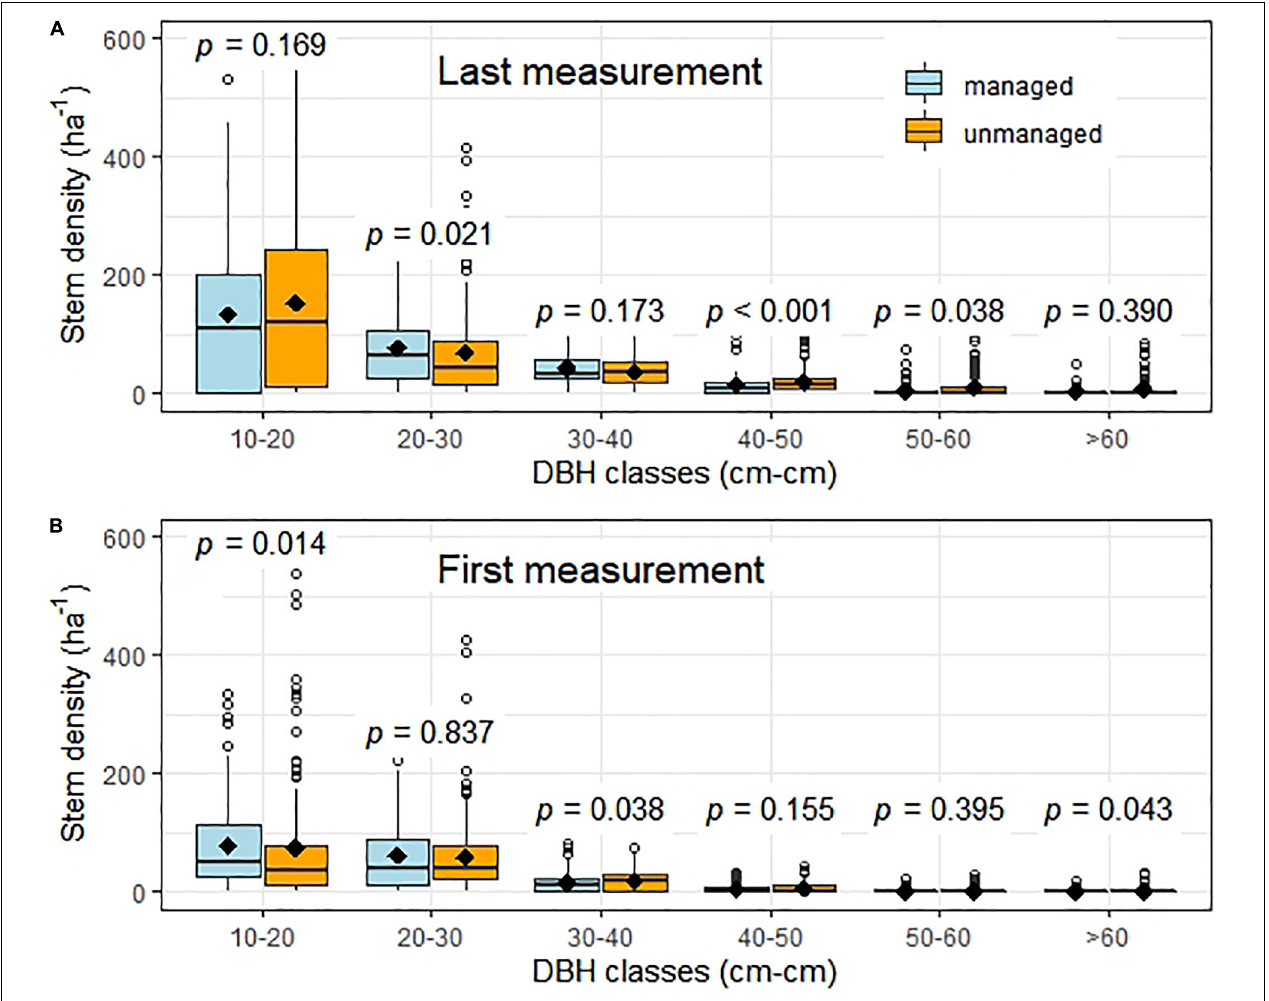
FIGURE 5 | Stem density distribution using 10 cm classes of diameter at breast height (DBH) for managed (left) and unmanaged plots (right). In panel (A) , we show results for the last measurement and in (B) for the first measurement. For details on boxplots see caption of Figure 4